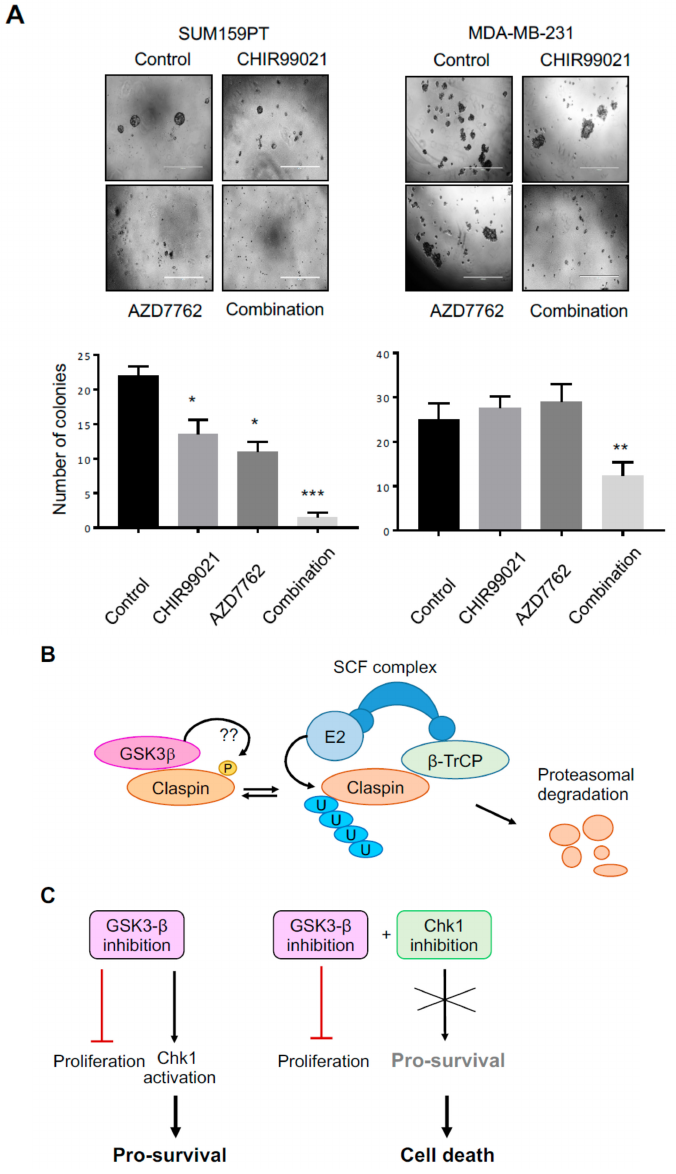
Figure 5. GSK3- β / Chk1 double inhibition reduces proliferation in three dimensional cultures. ( A ) Top panels, representative images of SUM159PT and MDA-MB-231 spheroids grown on Matrigel for 14 days treated with or without CHIR99021 (10 µ M) and AZD7762 (100 nM) both alone and in combination. Bottom panels, quantification of a number of tumour spheroids treated with or without each treatment. One-way ANOVA followed by Bonferroni post-tests were employed. Values indicate mean ± SD ( n = 3). *, p < 0.05, ** p < 0.01, ***, p < 0.001. ( B ) Schematic model on how GSK3- β can modulate Claspin stability. “U” represents ubiquitin and “P” represents phosphorylation. ( C ) Model on the GSK3- β and Chk1 inhibition on inhibiting proliferation and promoting cell